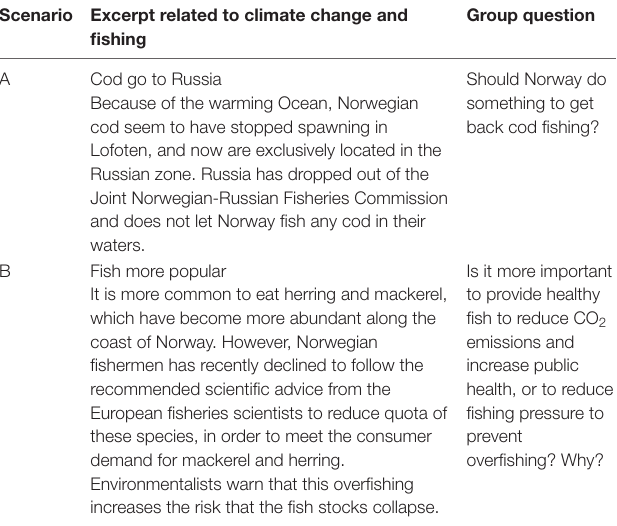
TABLE 1 | The scenarios and questions used in the citizens’ workshop in Bergen, Norway (June